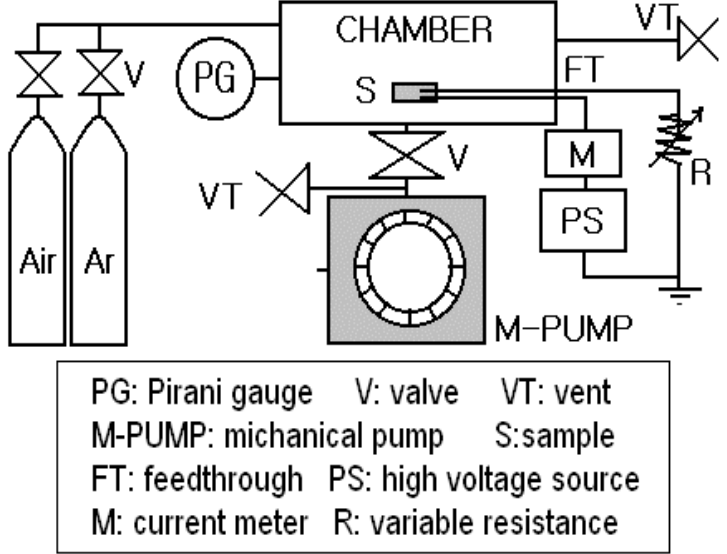
Figure 4. A diagram of experimental setup for testing the